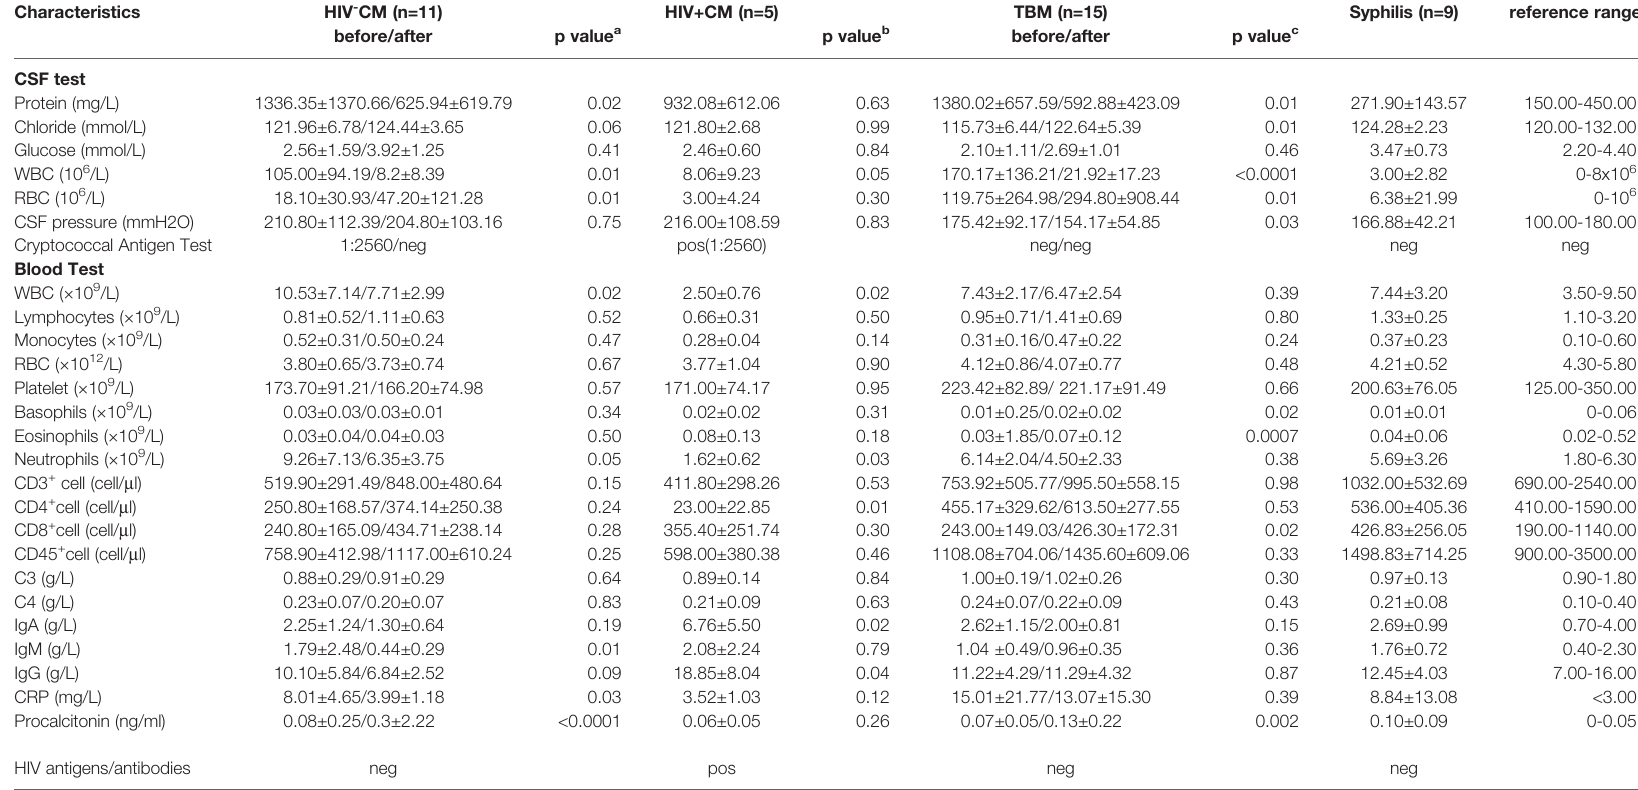
Data are shown as mean ± SD. CM, Cryptococcus neoformans meningitis; TBM, tuberculous meningitis; before, before therapy; after, after therapy; CSF, cerebrospinal fl uid; WBC, white blood cells; RBC, red blood cells; CRP, C-reactive protein. a P-value indicates HIV - CM before compared with HIV - CM after. b P-value indicates HIV - CM before compared with HIV + CM. c P-value indicates TBM before compared with TBM